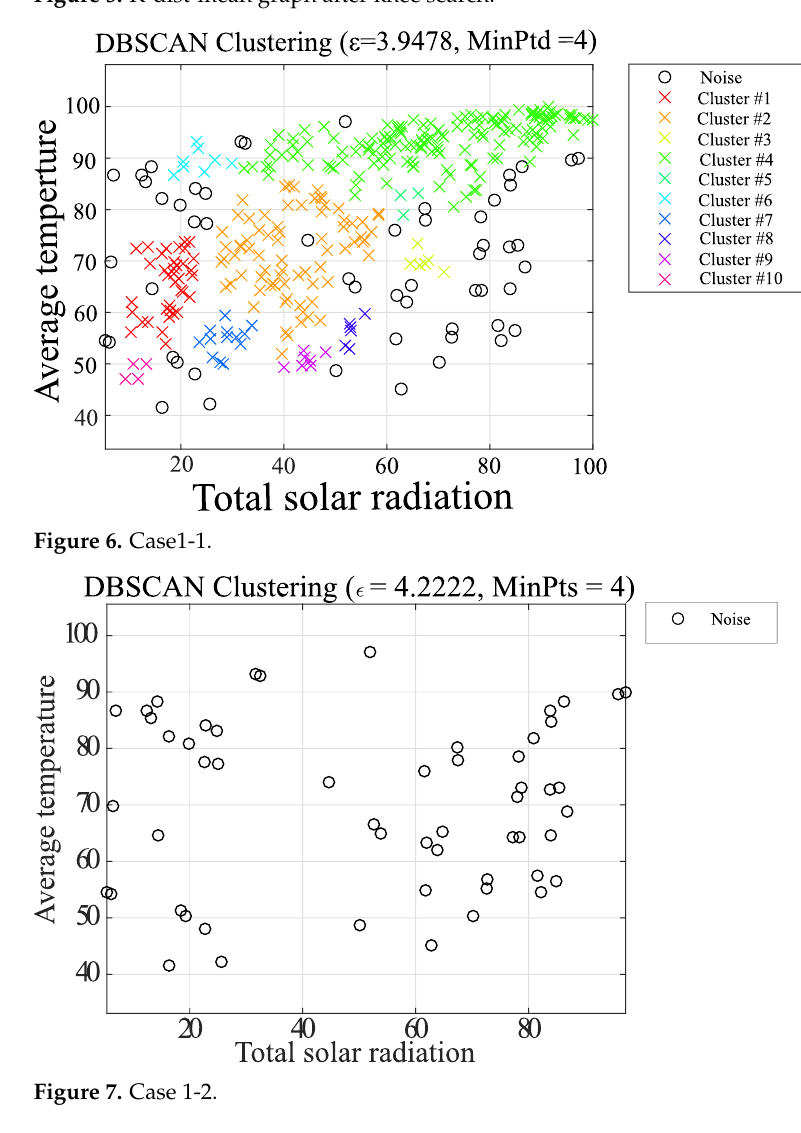
Figure 5. K-dist-mean graph after knee search.